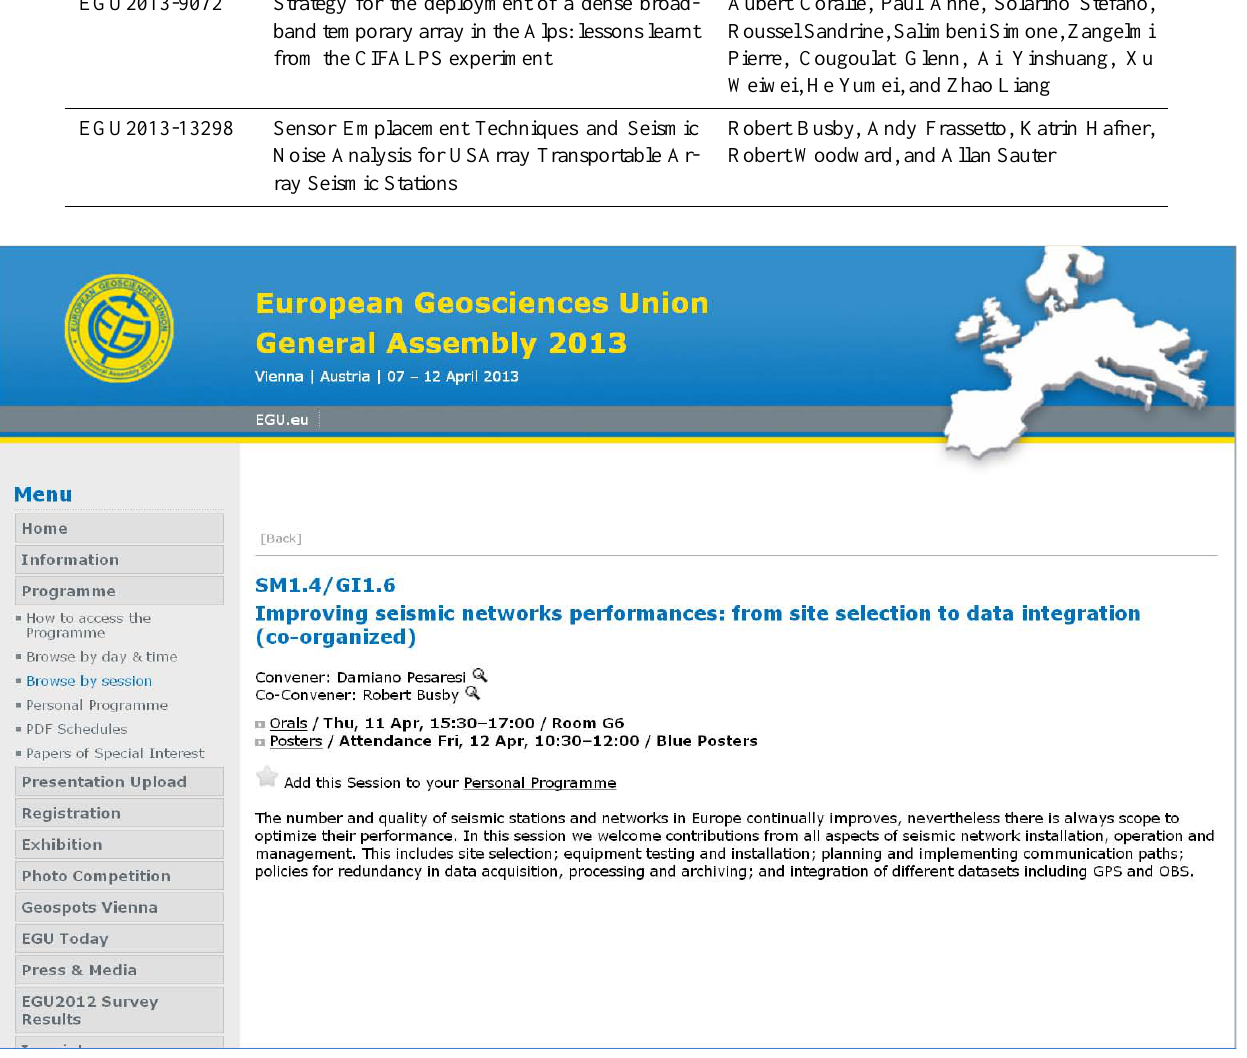
Fig. 1. EGU2013 SM1.4/GI1.6 session (from EGU2013